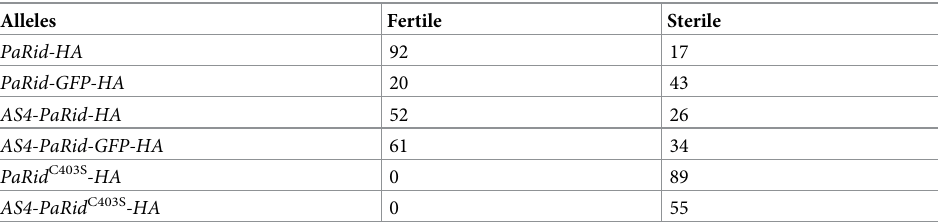
Table 1. Complementation